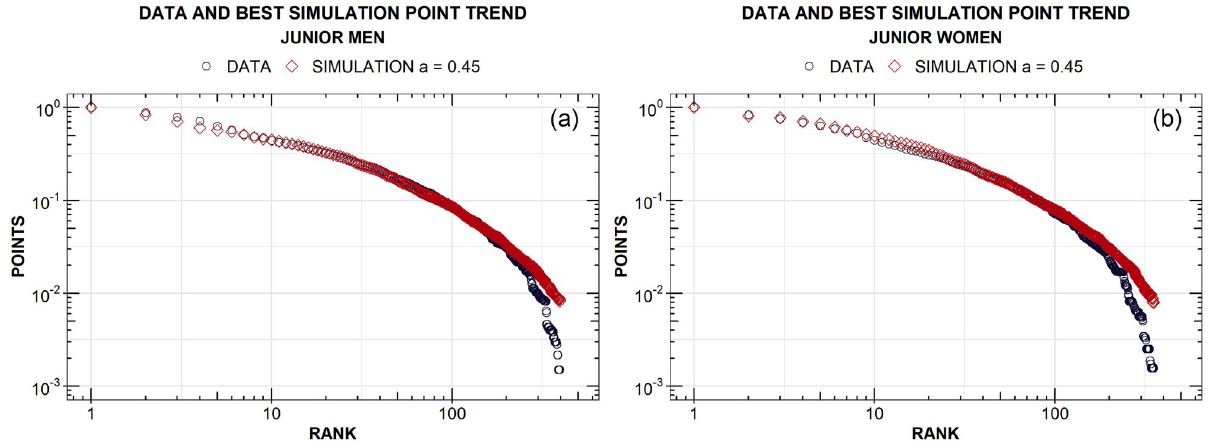
Fig 5. Trend of the average total points in Junior rankings, normalised to their maximum value, compared to simulations for male (a) and female (b) fencers.